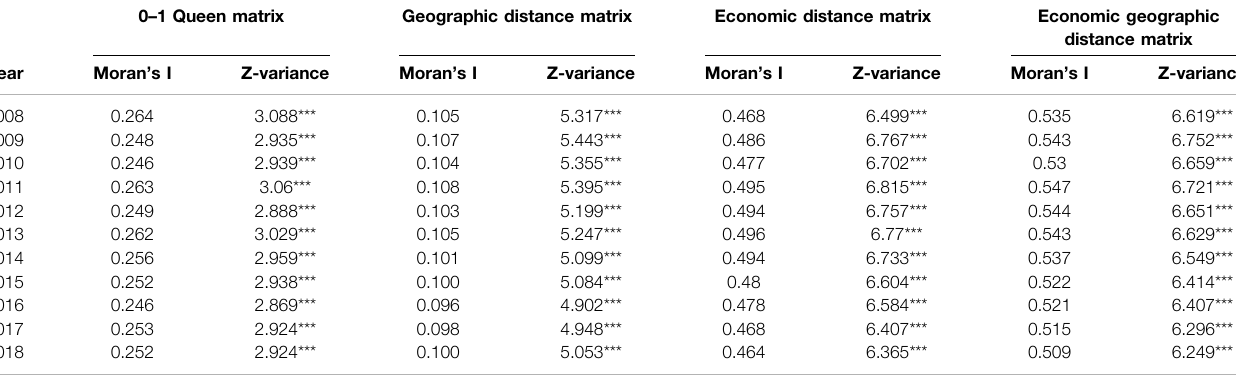
TABLE 3 | Moran ’ s I index of the degree of coupling coordination between urban resilience and transportation infrastructure in the Yangtze River Delta from 2008 to 2018. 0 – 1 Queen